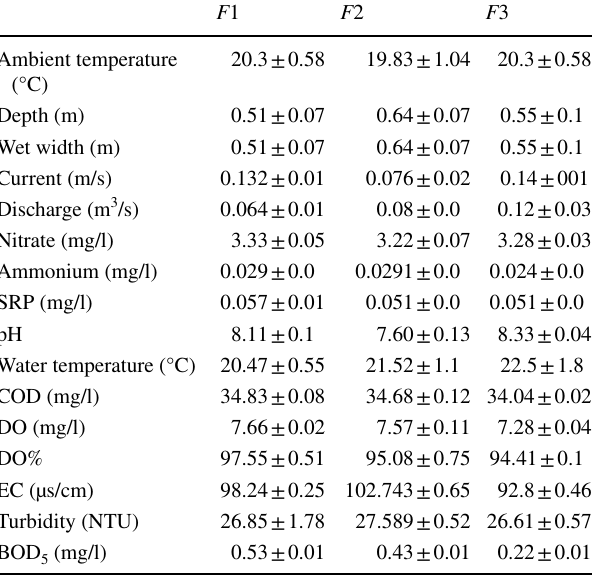
Table 3 Mean (± SE) values for measured physicochemical charac- teristics of three study sites in forest